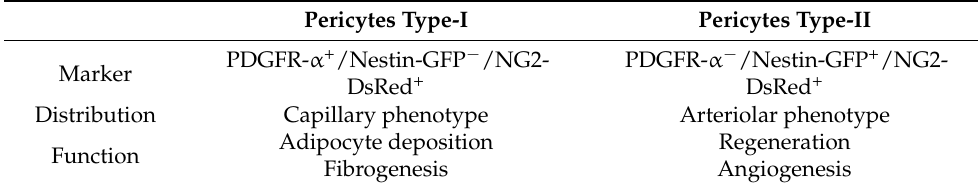
Table 1. Difference between pericytes (PCs) type-I and type-II. PDGFR, platelet-derived growth factor